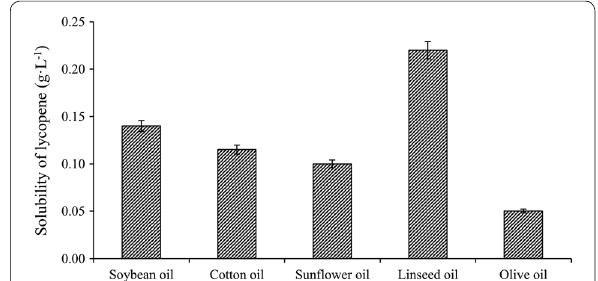
Fig. 2 Solubility of lycopene in different plant oils. Error bars indicate SEs of mean values